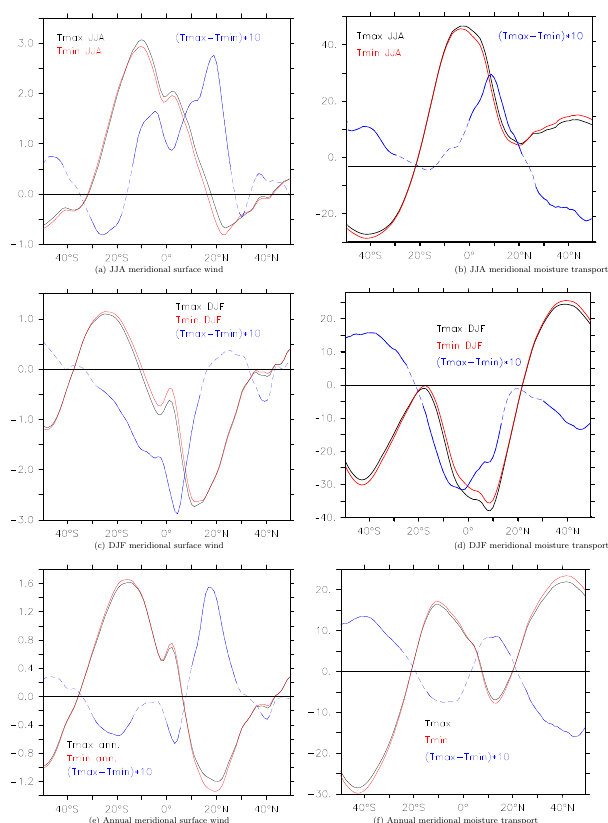
Figure 6. Zonal mean meridional surface wind and moisture trans- port for JJA (a, b) , DJF (c, d) and annual mean (e, f) . The wind is given in ms − 1 , moisture transport in kg(ms) − 1 for both T max (black) and T min (red) as well as the difference (blue, multiplied by 10 for clarity). Moisture transport is calculated as the mass- weighted vertical integral of specific humidity multiplied by hori- zontal wind. Positive values indicate northward wind or moisture transport, whereas negative values indicate southward. Wind and moisture transport into the summer hemisphere is stronger during T max for JJA (a, b) and DJF (c, d) . Solid parts of the blue line in- dicate where the difference is statistically significant at 95% (based on a two-sided Student t test). Note that the vertical scales are dif-